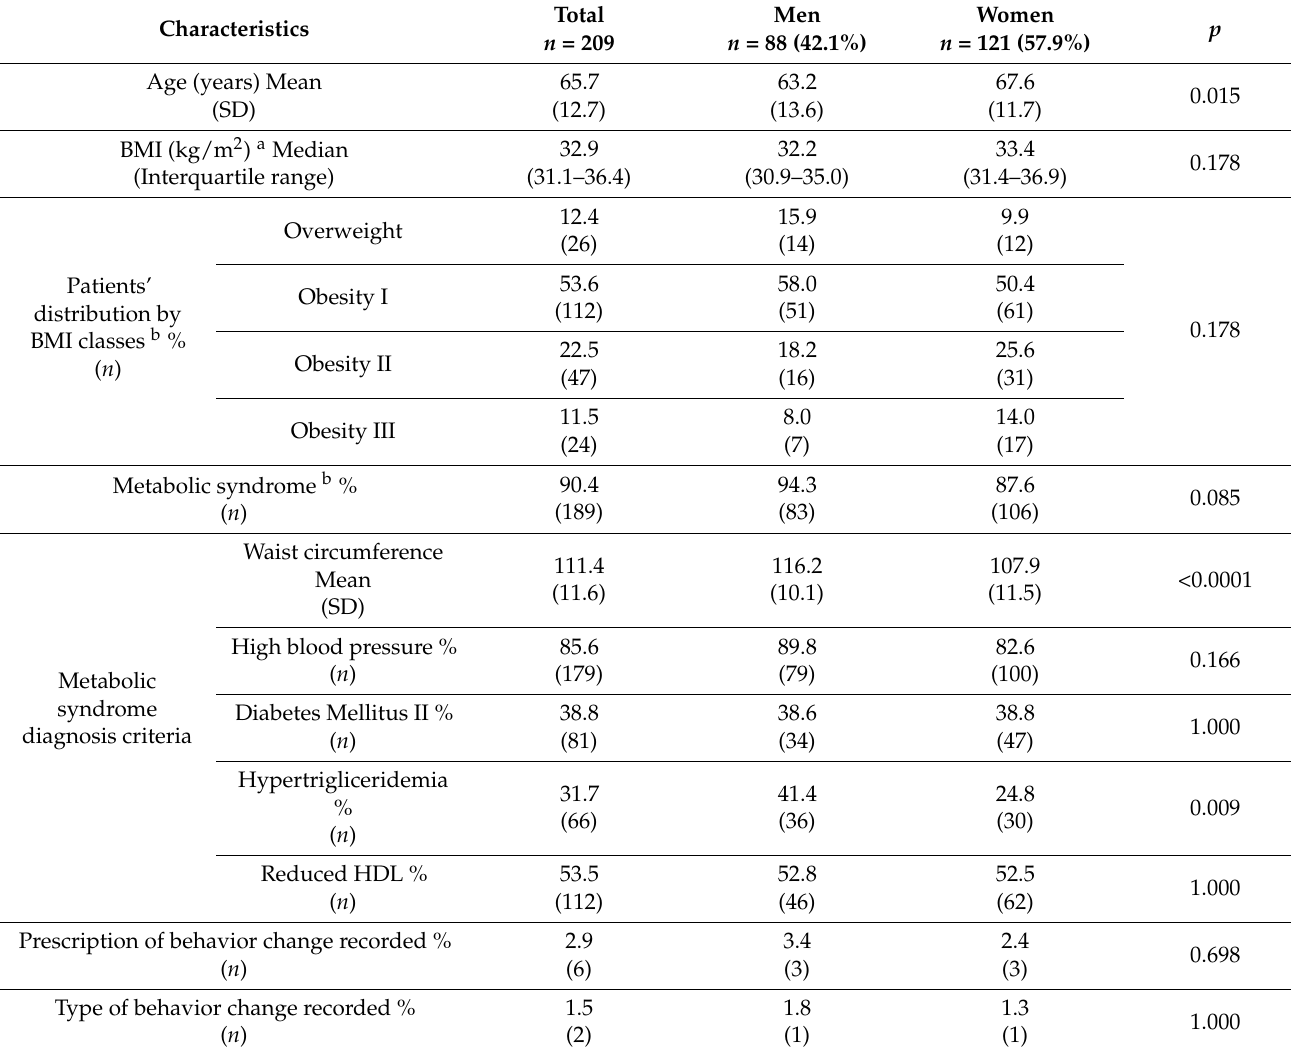
Table 1. General characteristics of the